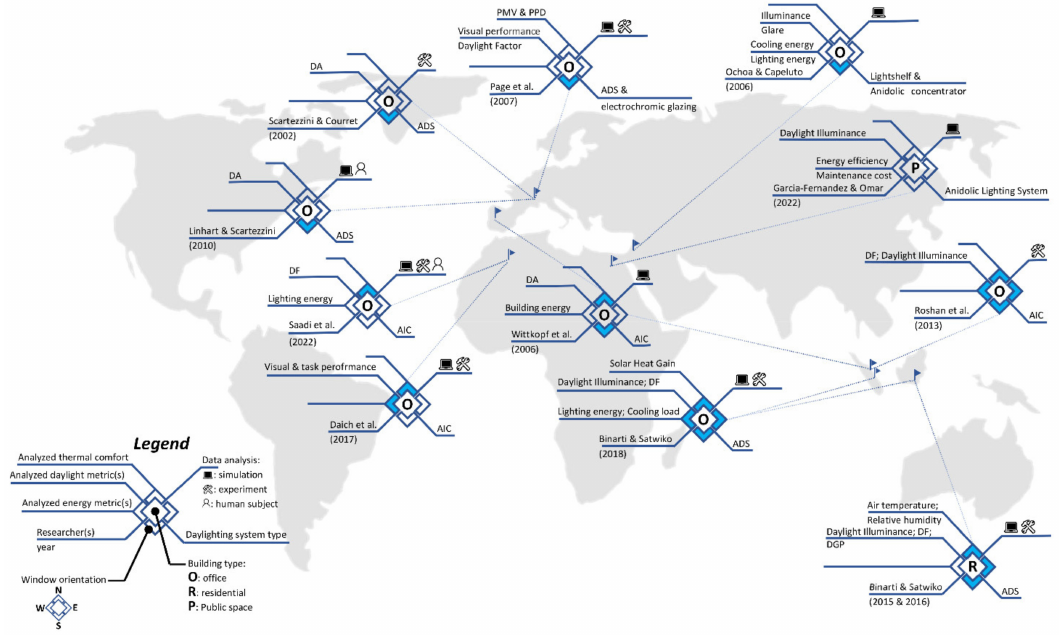
Figure 1. Previous research on